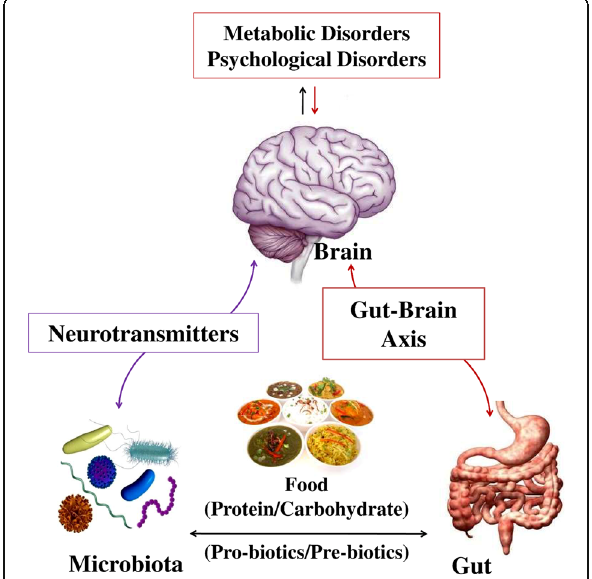
Fig. 2 Relationship between metabolic disorders and psychological disorders. Prebiotics and probiotics demonstrated beneficial effect on brain through modulation of neurotransmitters and glucose homeostasis, and showing bidirectional link between gut-microbiota and gut-brain